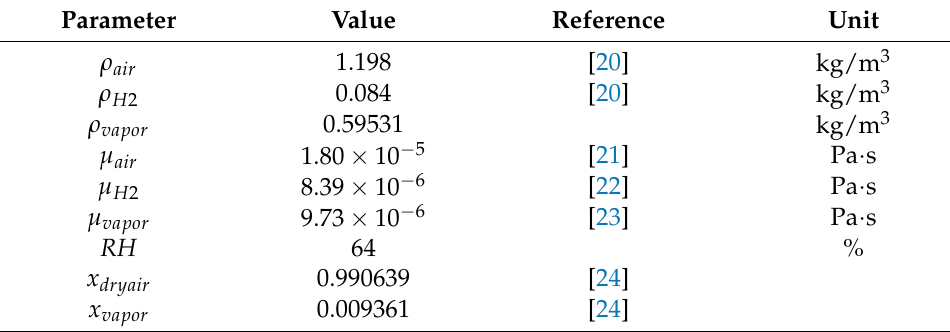
Figure 2. Computational domain and grid: ( a ) Boundary conditions for the atmospheric space above DLWL around the ship. ( b ) Composing mesh for the domain. ( c ) Grid dependency of the volume of FZ ( V fz ) based on the grid numbers ( N g ). Table 1. Gas properties of the computational domain.